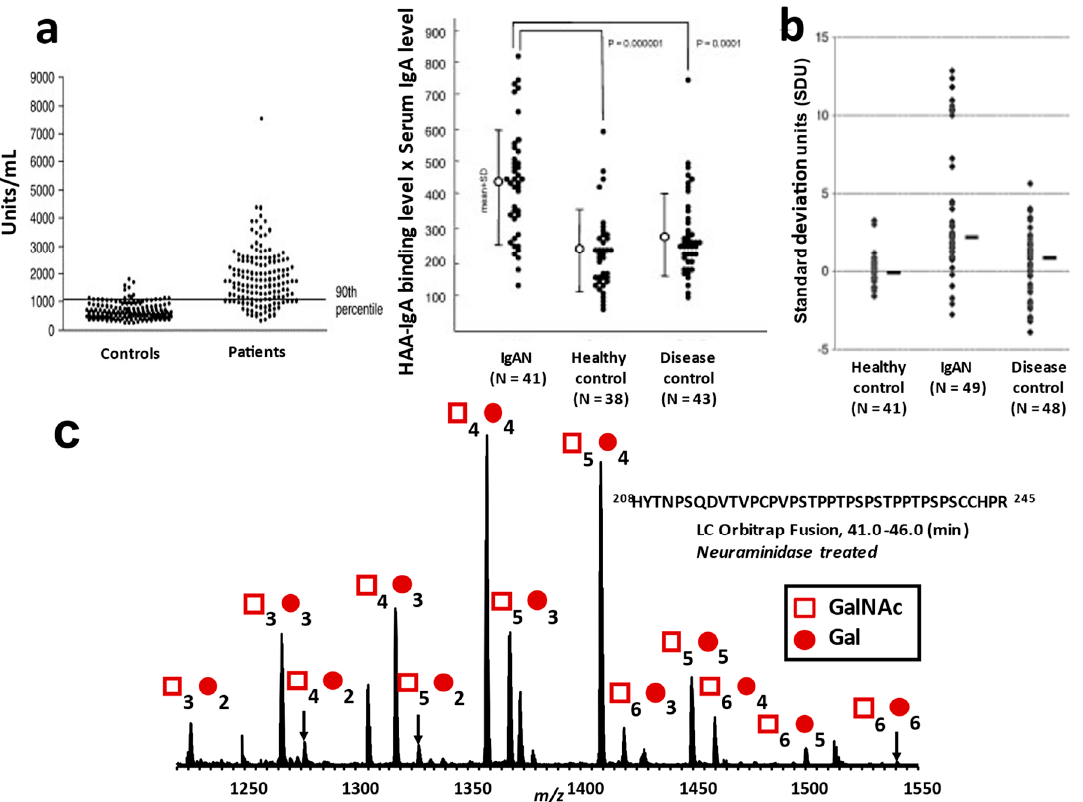
Figure 5. Detection of galactose-deficient IgA1 (Gd-IgA1). Serum Gd-IgA1 levels measured by Helix aspersa agglutinin (HAA)-based ELISA, due to HAA specificity for terminal GalNAc, is significantly higher in patients with IgAN than in healthy subjects ( a ) [32,33]. The left figure of ( a ) was published in Kidney International 2007, 71, 1148-54, Moldoveanu, Z. et al., Copyright 2007 Elsevier Inc and is republished with permission. The right figure of ( a ) is republished with permission of Oxford University Press, from Nephrology Dialysis Transplantation 2008, 23, 1931-9, Shimozato, S. et al., Copyright 2008 Oxford University Press. Detection of Gd-IgA1 using monoclonal antibody against human Gd-IgA1 hinge region (HR) peptide ( b ) [154]. The figure ( b ) was published in Journal of Nephrology 2015, 28, 181-6, Hiki, Y. et al., Copyright 2014, The Author(s). This article is under the terms of the Creative Commons CC BY license. A variety of IgA1 HR O- glycoforms can be detected by high-resolution mass spectrometry according to the difference in mass arising from the number of attached monosaccharides to the amino acid backbone of the IgA1 HR (His 208 -Arg 245 ). The number of N -acetylgalactosamine (GalNAc; □ ) and galactose (Gal; ● ) are shown above the individual peaks ( c ).